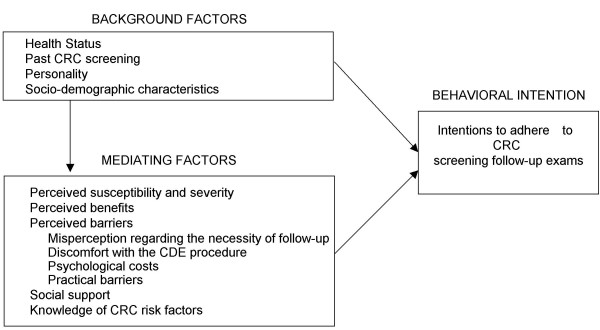
Conceptualization of factors associated with intentions to adhere to CRC screening follow-up exams.